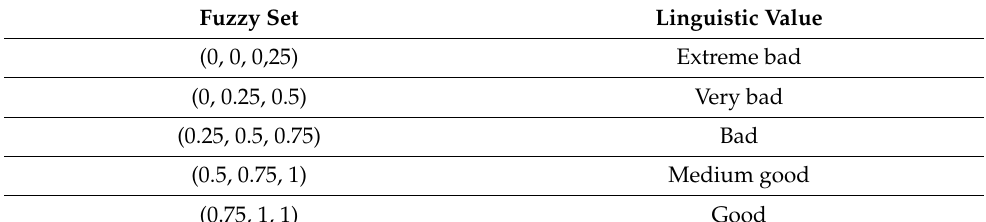
Table 3. Fuzzy sets of structural importance of elements with linguistic values.